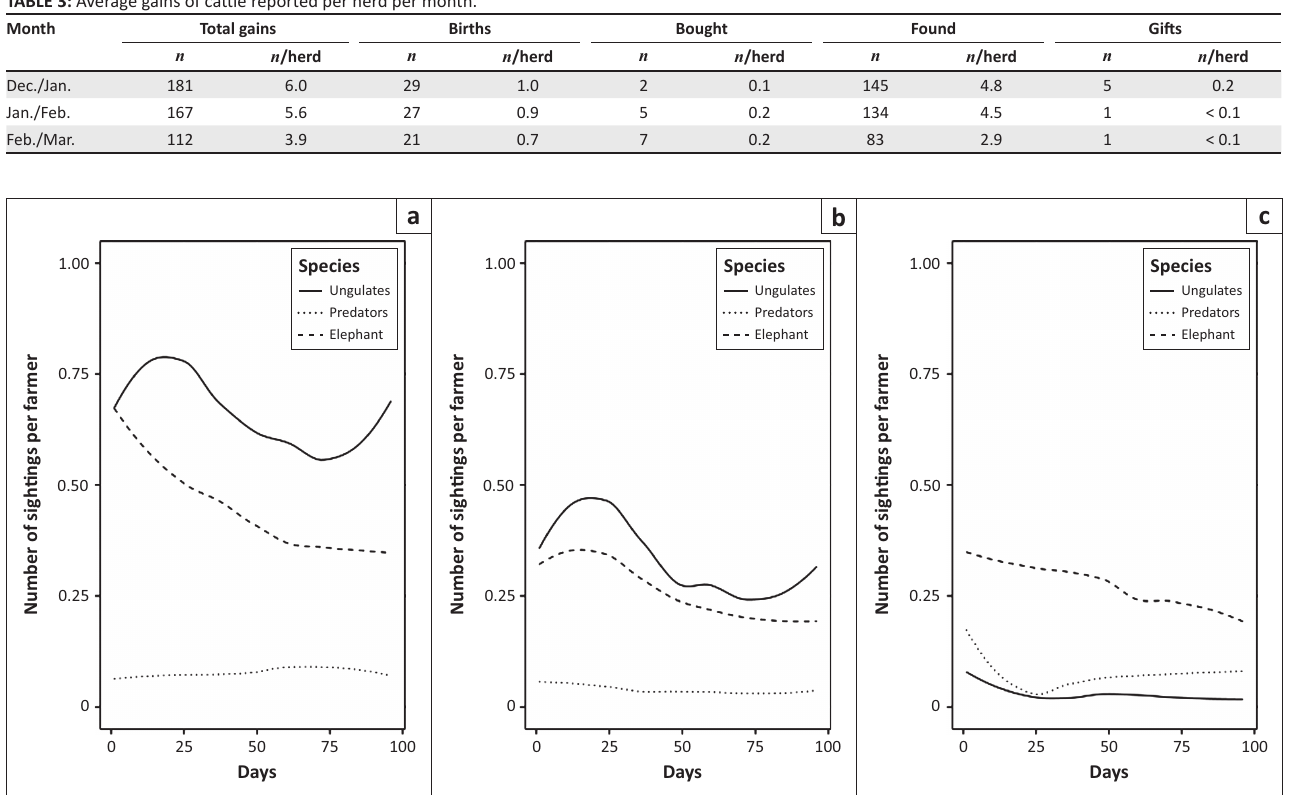
FIGURE 3: Number of daily sightings per farmer of elephant, predators and ungulates for the period December 2014–March 2015. (a) Grazing area, (b) watering point and (c)